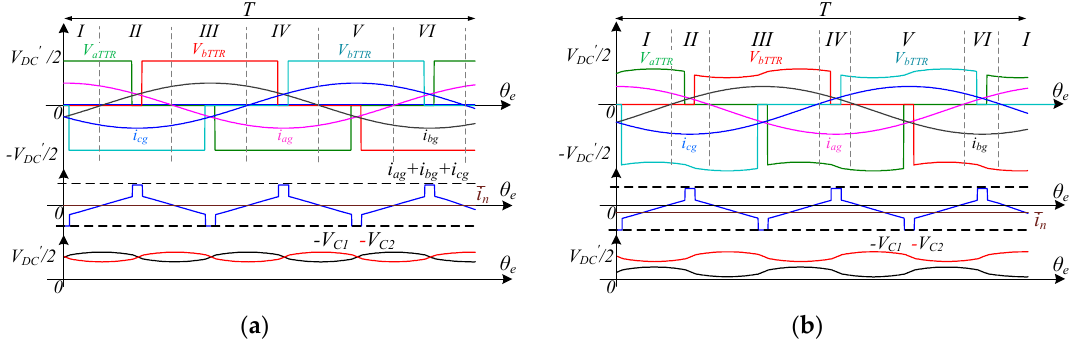
Figure 5. Averaged-value i n , i abcg , V c1 , V c2 , and V iTTR . ( a ) Balanced DC bus voltages, and ( b ) unbalanced DC bus voltages.